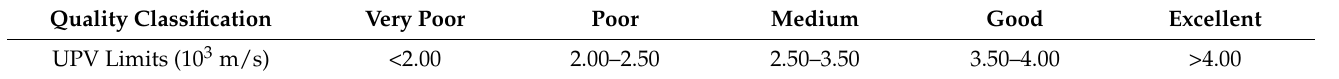
Table 9. Classification of the quality of concrete based on the UPV